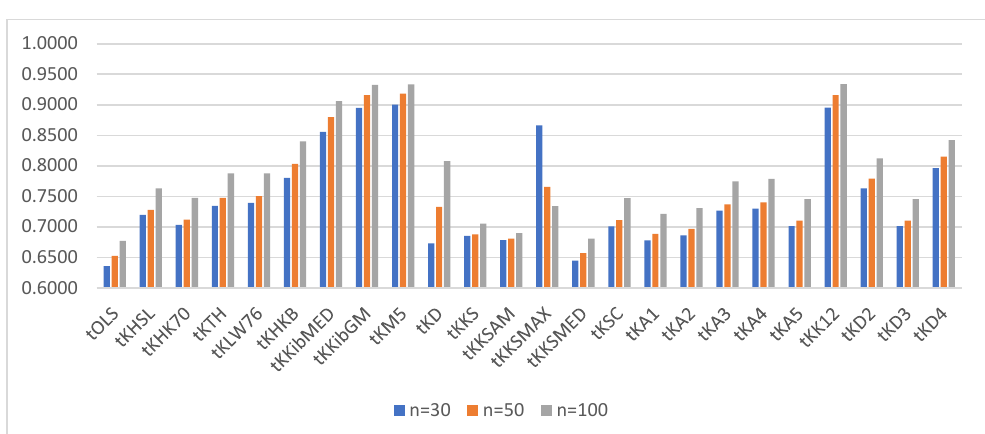
Figure 1. Power of the test for correlation coefficient 0.80 and q = 4.